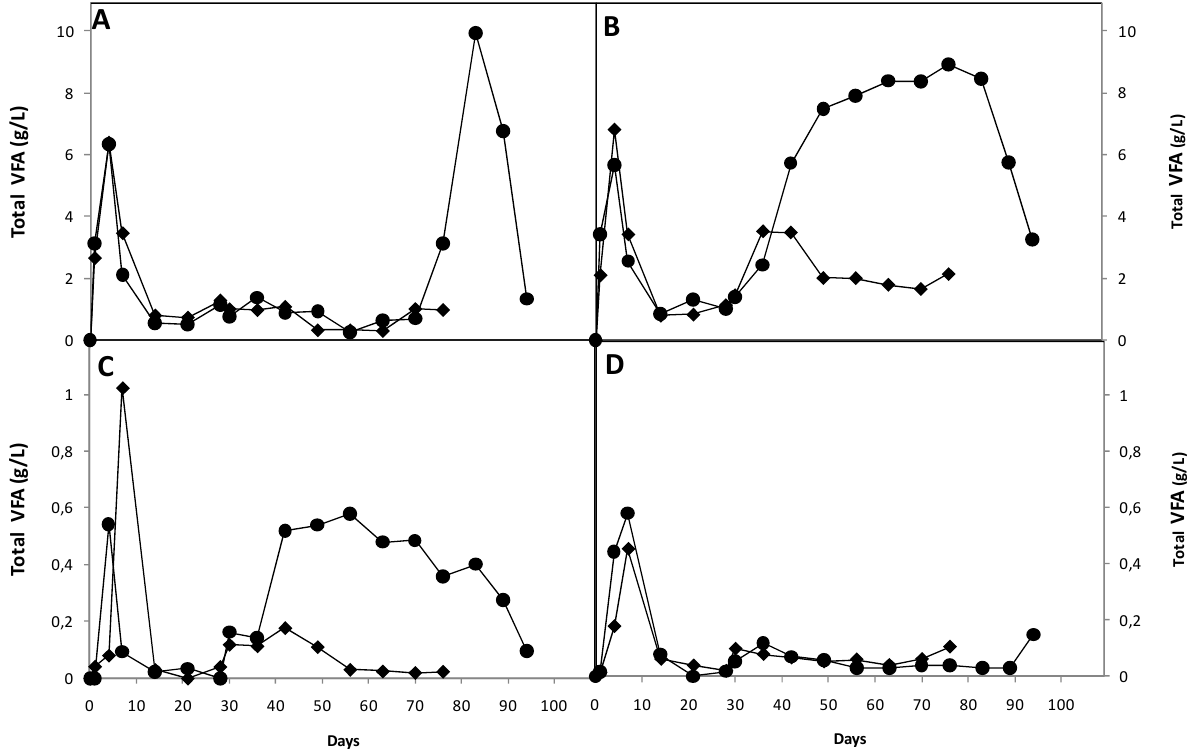
Figure 3. Volatile fatty acid concentration during the experimental period. ● - Starch; ♦ - Cotton. ( A ) CSTR closed system; ( B ) UASB closed system; ( C ) CSTR open system; ( D ) UASB open